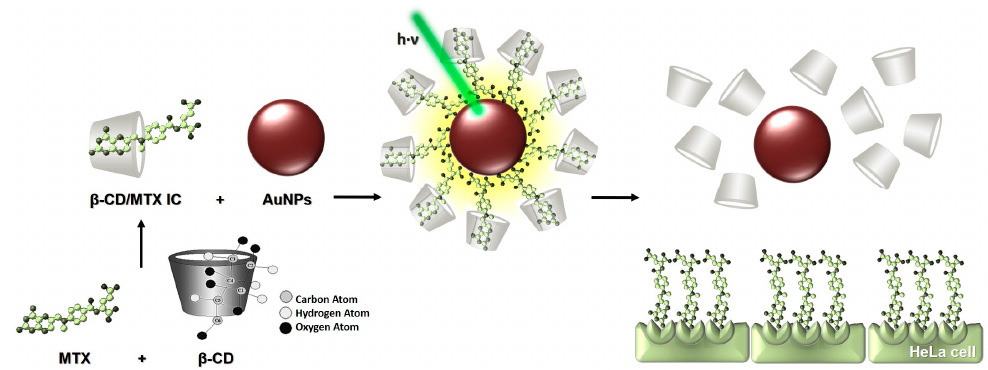
Figure 1. Schematic representation of the precursors MTX and β -CD to form the inclusion compound (IC) and subsequently of the ternary system, where the IC was conjugated to the AuNP. Laser light is absorbed by the AuNP and is transformed into local heat, which is dissipated into the environment and induces the release of MTX from the CD cavity. Further, the free drug interacts with the folate receptors in the HeLa cells.